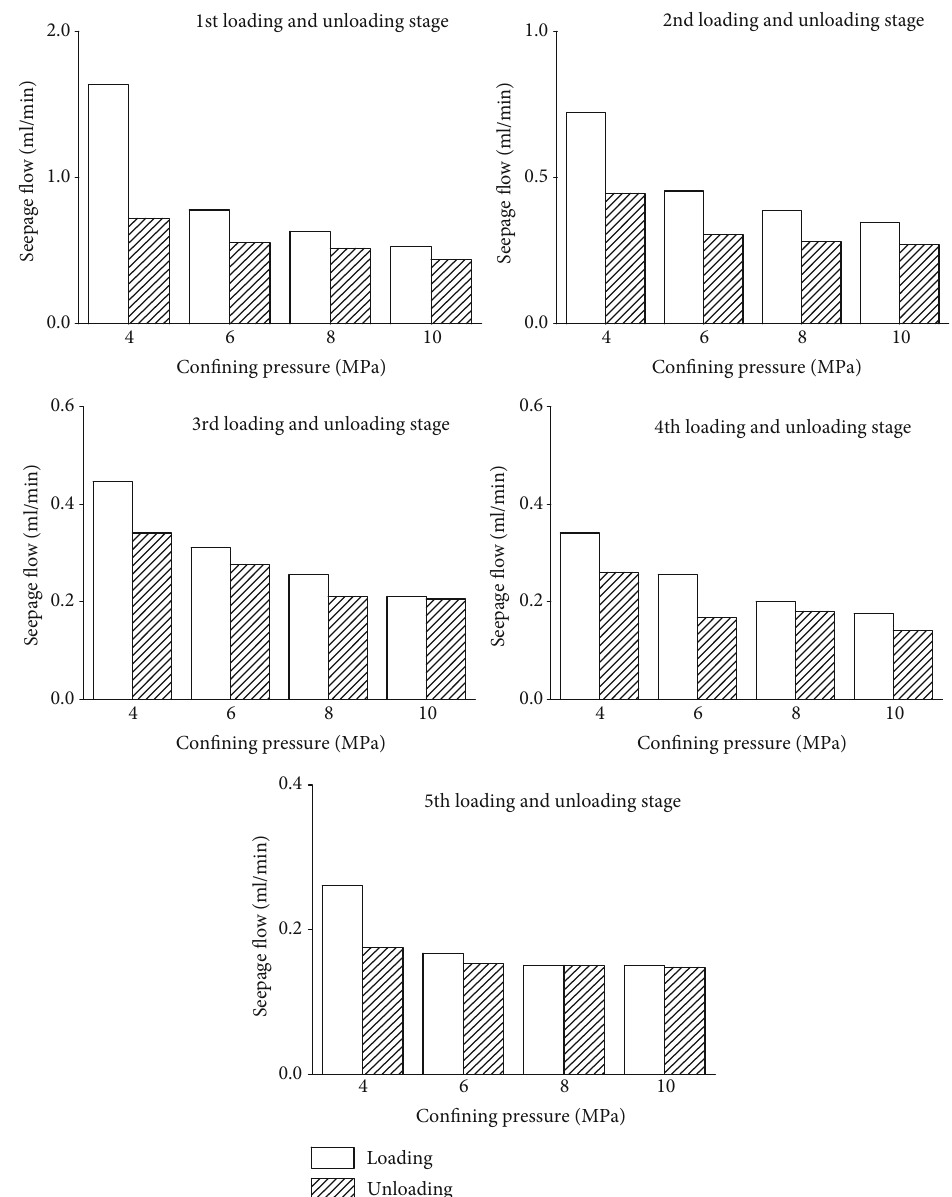
Figure 11: Comparison of seepage fl ow in cyclic loading-unloading con fi ning process of postpeak fractured